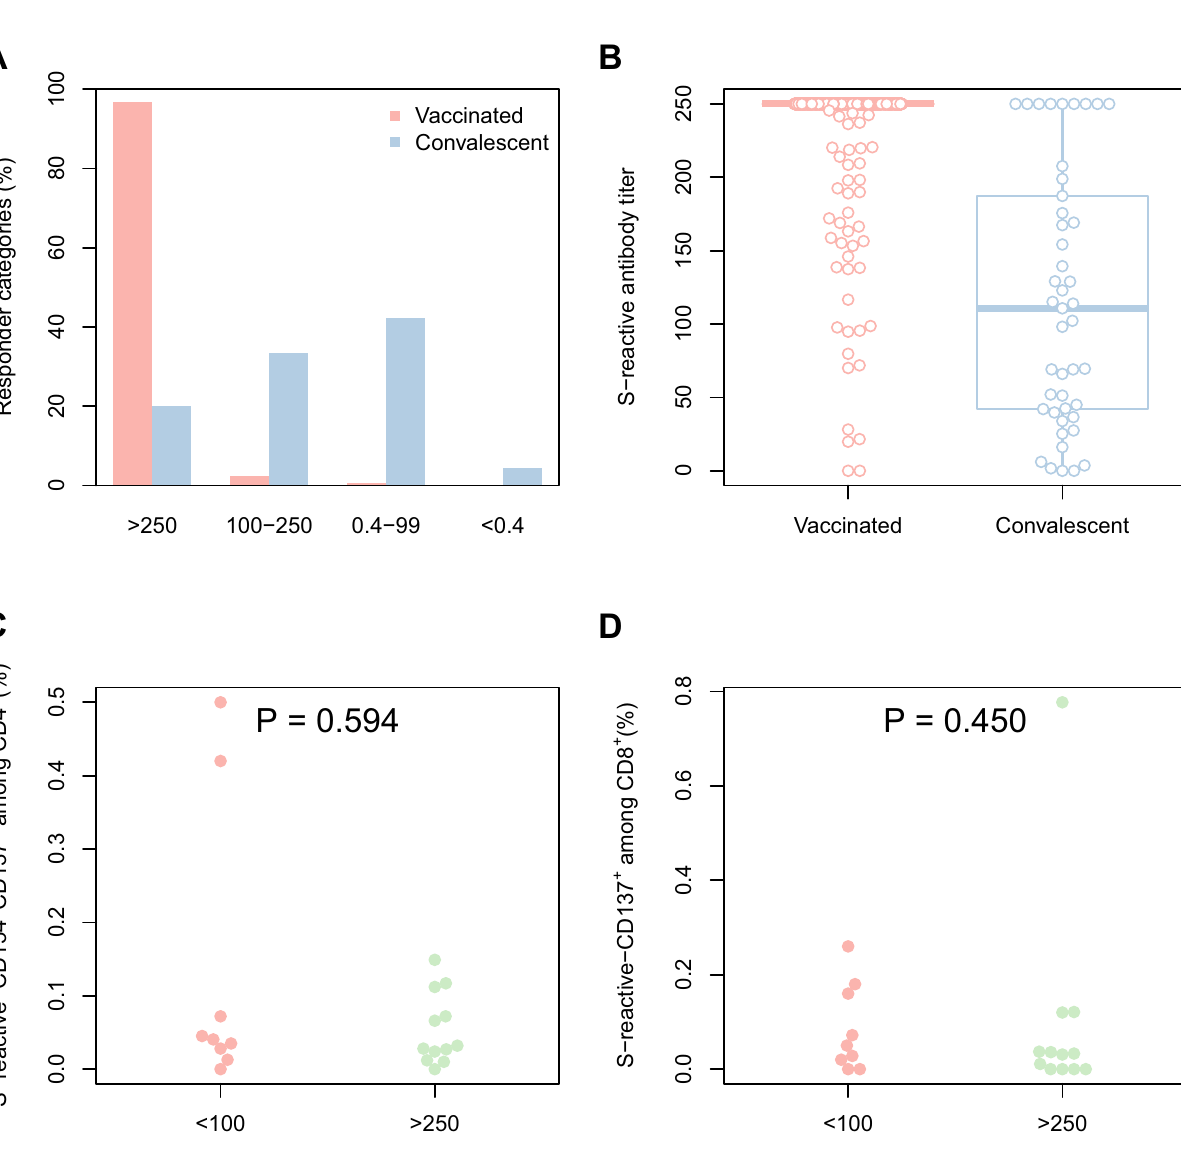
Figure 1. ( A ) Distribution of quantitative Anti-SARS-CoV-2 IgG response of vaccinated and convalescent healthcare workers. ( B ) S (spike protein) − reactive antibody titers of vaccinated (median 250, IQR 250–250) and convalescent (110.7, IQR 40.9–193.1, p = 0.001 Mann Whitney test) healthcare workers. ( C ) SARS-CoV-2 spike protein reactive CD4 + (p = 0.59) and ( D ) CD8 + (p = 0.45) T-cells in healthcare workers with